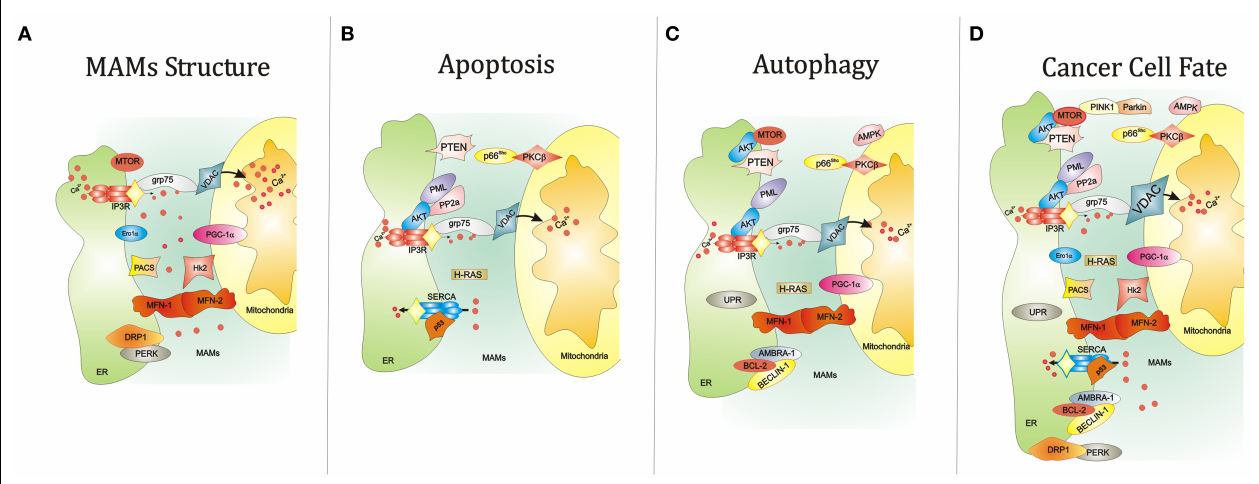
FIGURE 1 | Summary of the key functions of the ER-MAMs resident proteins . (A) Several proteins reside in MAMs compartment and regulate the juxtaposition between ER and mitochondria, including grp75, Ero1 α , PERK, and MFN-1/2. At the same time, other MAM resident proteins control the cell survival by governing apoptosis (B) and autophagy (C) . For example, it has been reported that PML, IP3R3, and AKT mutually interact to allow the correct Ca 2 + -movement between ER and mitochondria, an essential proapoptotic signal. Interestingly, the maintenance of this interorganelle Ca 2 + -communication is also important for the autophagic process. Of relevance, reductions of mitochondrial Ca 2 + accumulation may trigger autophagy. In parallel, most of MAM proteins also govern the autophagic machinery. Of relevance, AKT and MTOR regulate negatively autophagic process. The same work is executed by the molecular axis composed by p66 Shc and PKC β . It is widely accepted that autophagy is strictly linked to several human diseases, in particular cancer. Think about a possible link between autophagy, cancer, and MAMs is not so difficult. Several findings may suggest this. For example, the corrected maintenance of MAMs integrity by MFN-1/-2 and DRP1 is also crucial for autophagosome formation and tumor cell growth. (D) The autophagic regulator AMBRA-1 has been found to interact with both the oncogene BCL-2 and the tumor suppressor BECLIN-1.